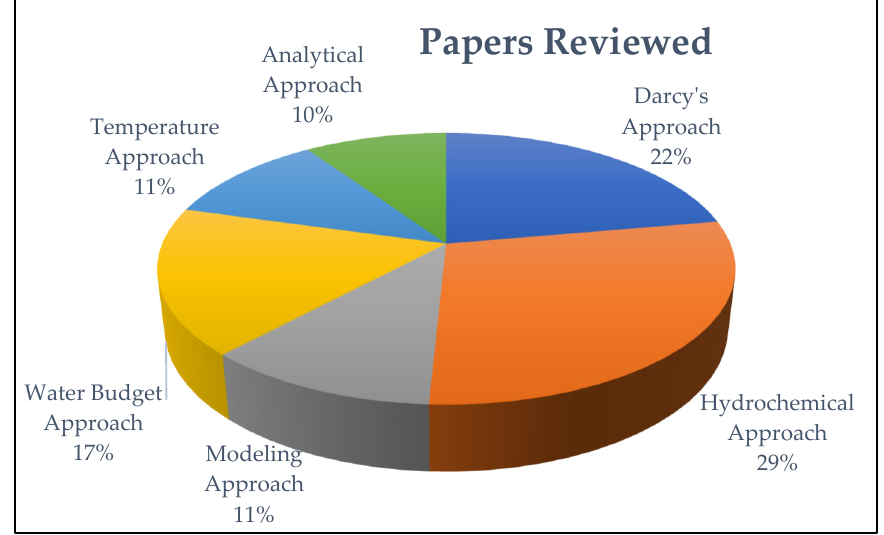
Figure 11. Share of the studies reviewed under each type of approach.